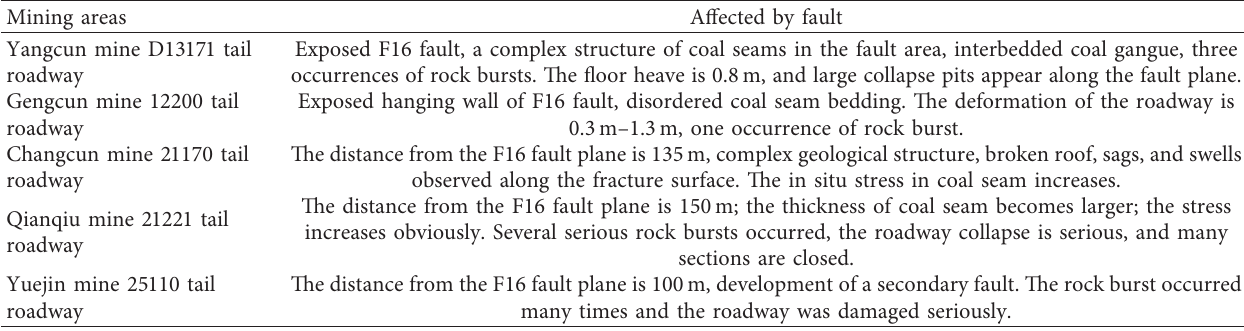
Table 1: The influence of F16 fault on mining engineering of each mine. Mining